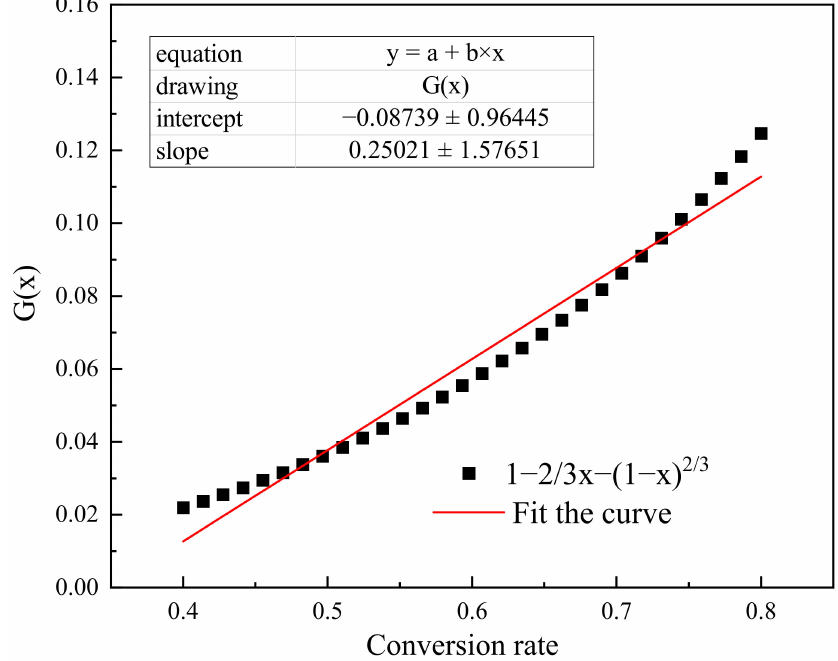
Figure 2. Fitting equation for the integral equation of the reaction function G ( x